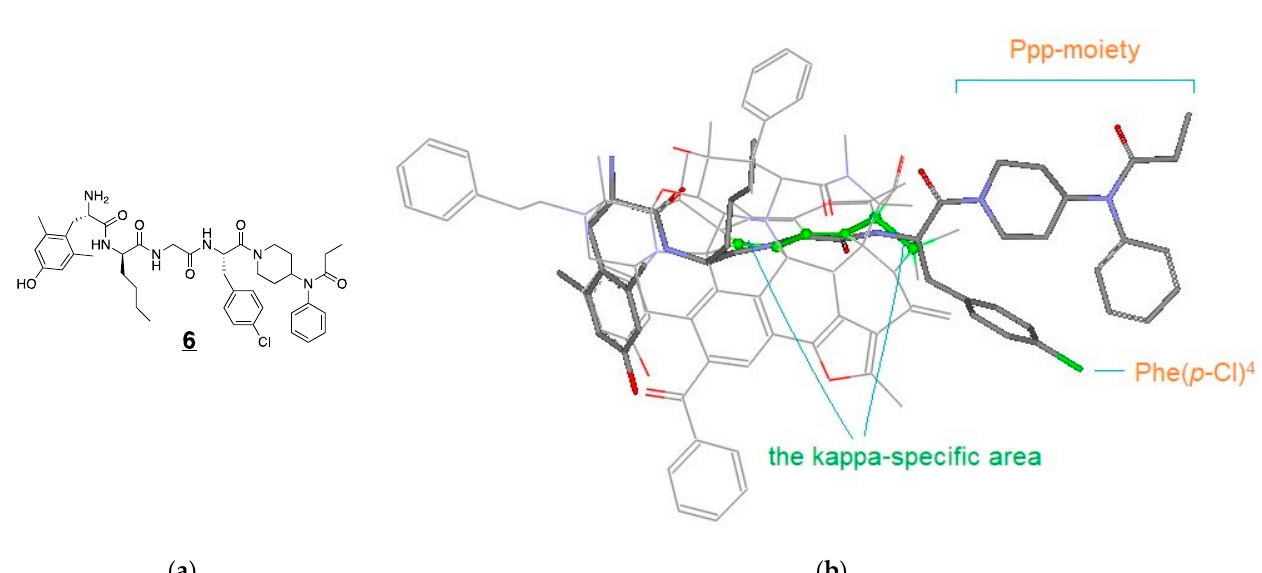
Figure 3. The structure of 6 ( a ) and alignment of the backbones of 6 along the kappa-specific area (light green) of the MOR agonist template ( b ).